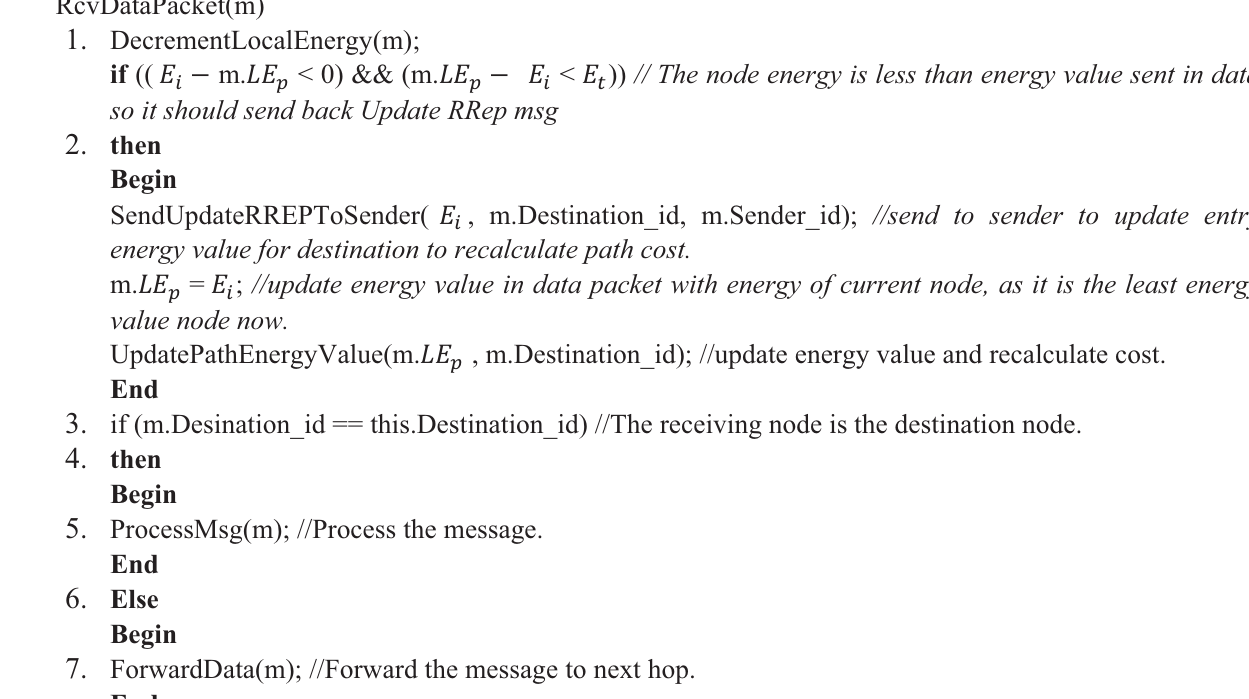
Figure 8. Algorithm to receive data